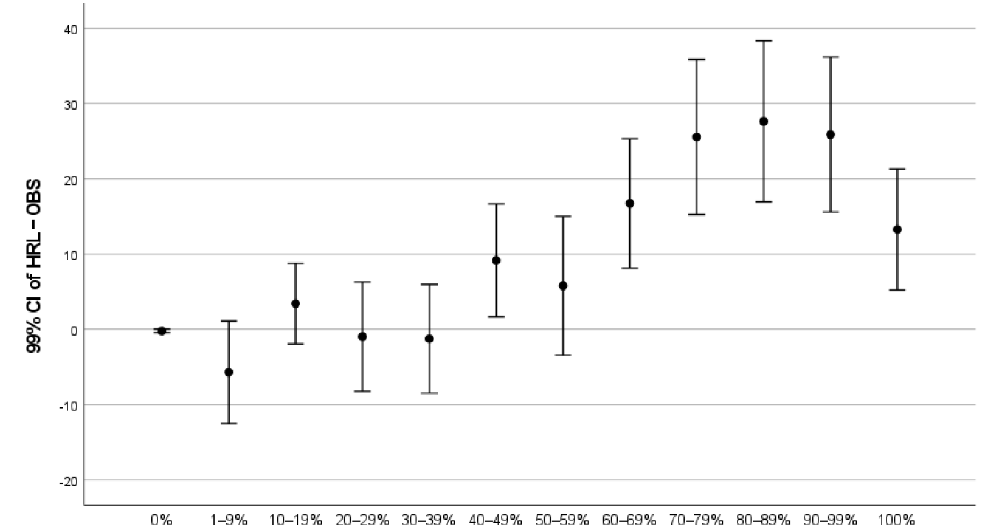
Figure 2. Mean difference between imperviousness reported by IMD and observed in orthophoto together with the 99% CI of these mean differences.